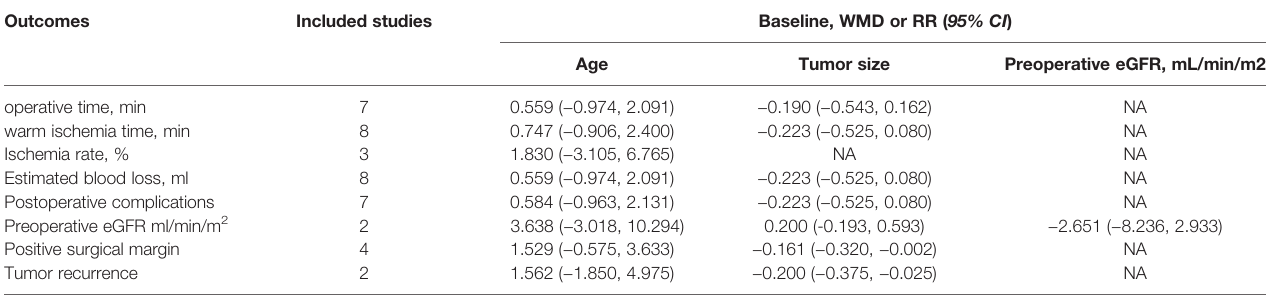
TABLE 2 | Summary of baseline characteristics and outcomes of different analyses.